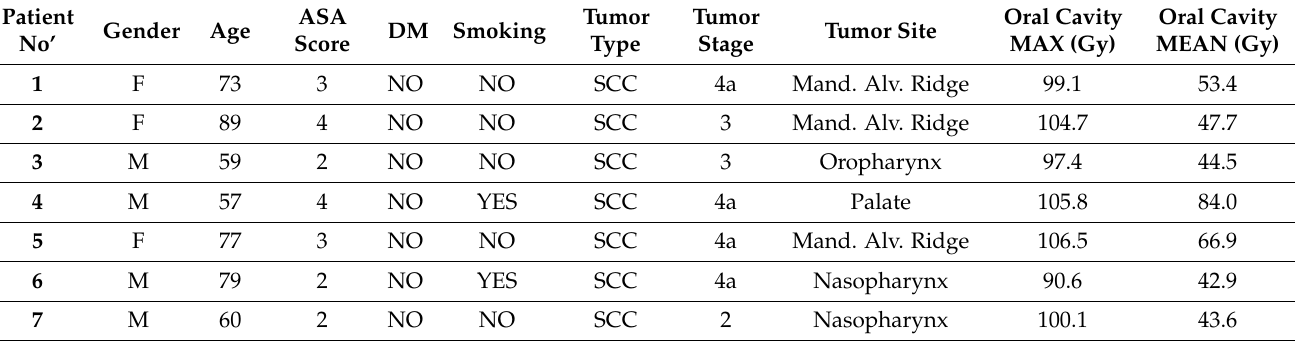
Table 5. ORN+ patients